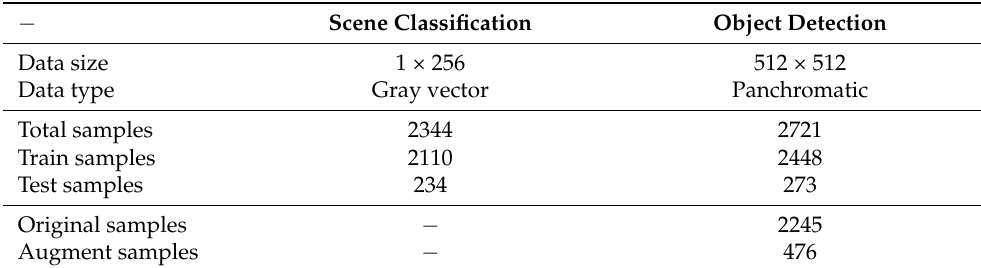
Figure 5. Schematic diagram of training sample blocks. The data set includes various types and sizes of ship targets in different scenes, as well as static targets and dynamic targets. At the same time, simulation samples are added to make up for the lack of samples in some scenes. Table 1. Dataset